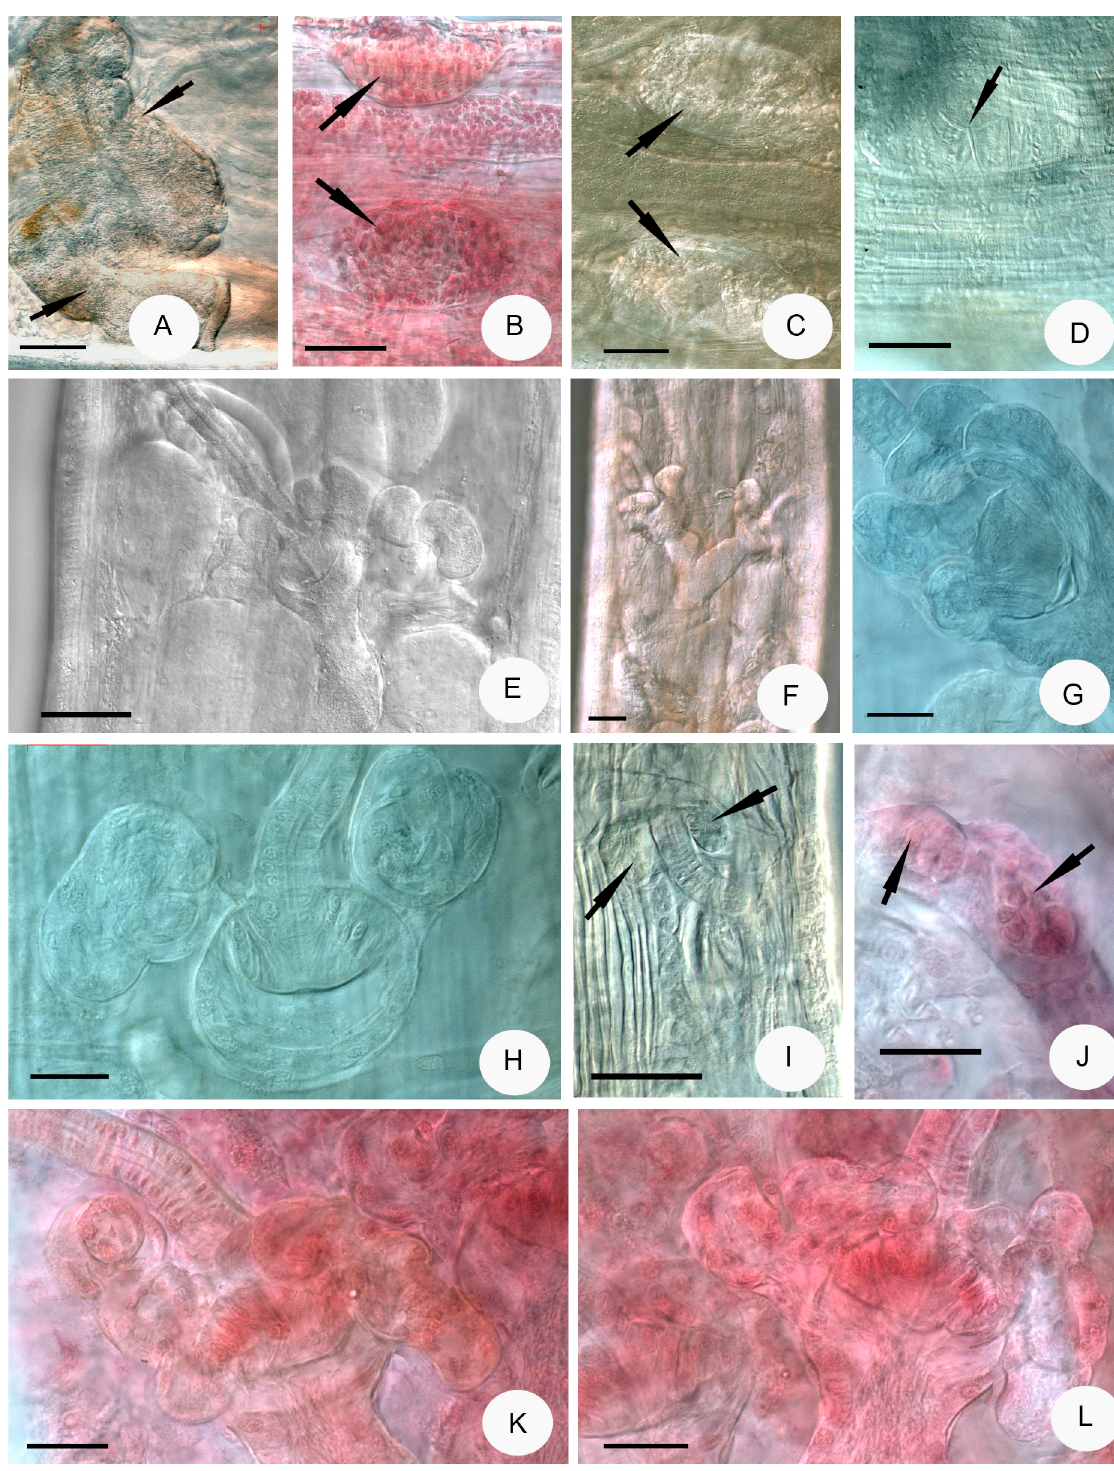
Fig. 3. Micrograph of Fridericia baradlana sp. nov. A. Sperm funnels (marked with arrows). B–C. Male copulatory organs (marked with arrows). D. Bursal slit (marked with arrow). E–H, K–L. Spermathecae. I–J. Spermathecal ectal glands (marked with arrows). (A, C, E–F in vivo , B, J, K–L fixed, stained, D, G, H–I fixed, not stained). Scale bars: 50 μm, in H, J–L 20 μm, J–L from